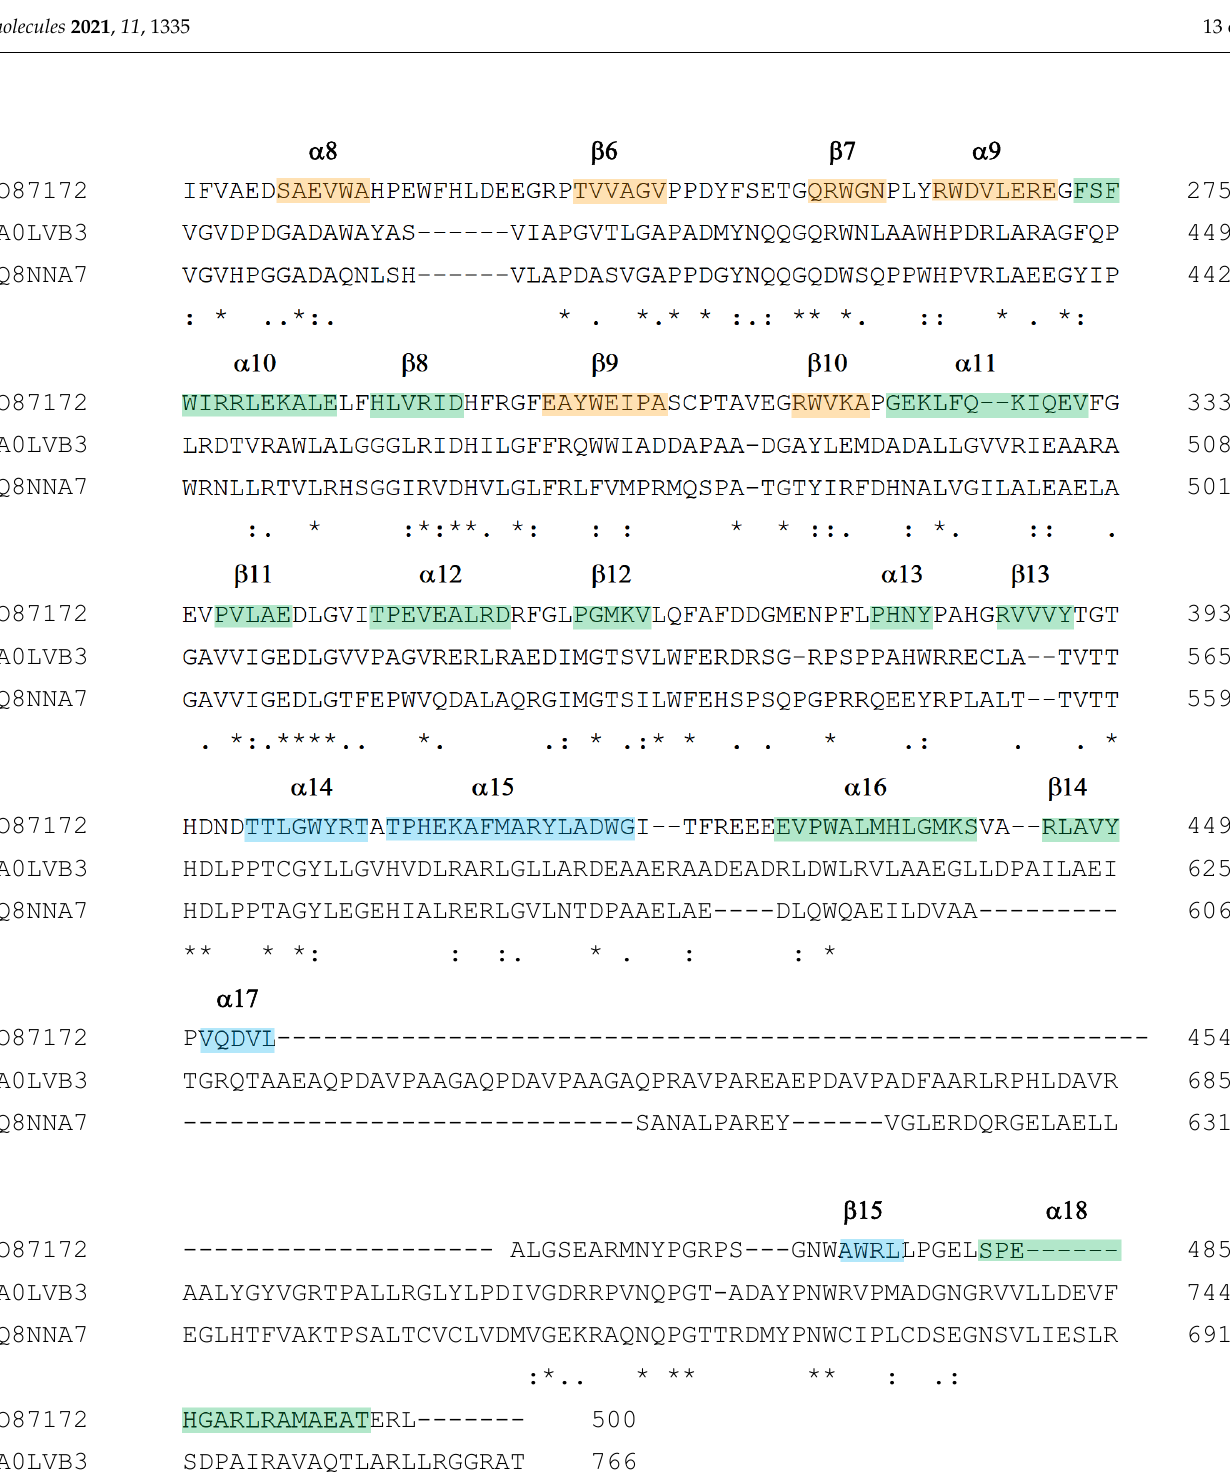
Figure 4. Multialignment of amylomaltases from A. cellulolyticus (A0LVB3), C. glutamicum (Q8NNA7) and T. thermophilus (O87172). Sequences of enzymes are indicated by their UniProt accession number (see Table 1). The order of the sequences and amino acids conservation symbols are as obtained by the Clustal program [54] (in particular, asterisks indicate identical residues; colons and dots indicate conserved and semi-conserved substitutions, respectively). Secondary structure description is related to amylomaltase from T. thermophilus according to the 3D structure described by Przylas et al. [51]. In particular, green regions refer to the ( β / α ) 8 TIM barrel (domain A); the other coloured regions correspond to subdomain B1 (orange), subdomain B2 (yellow) and subdomain B3 (cyan).